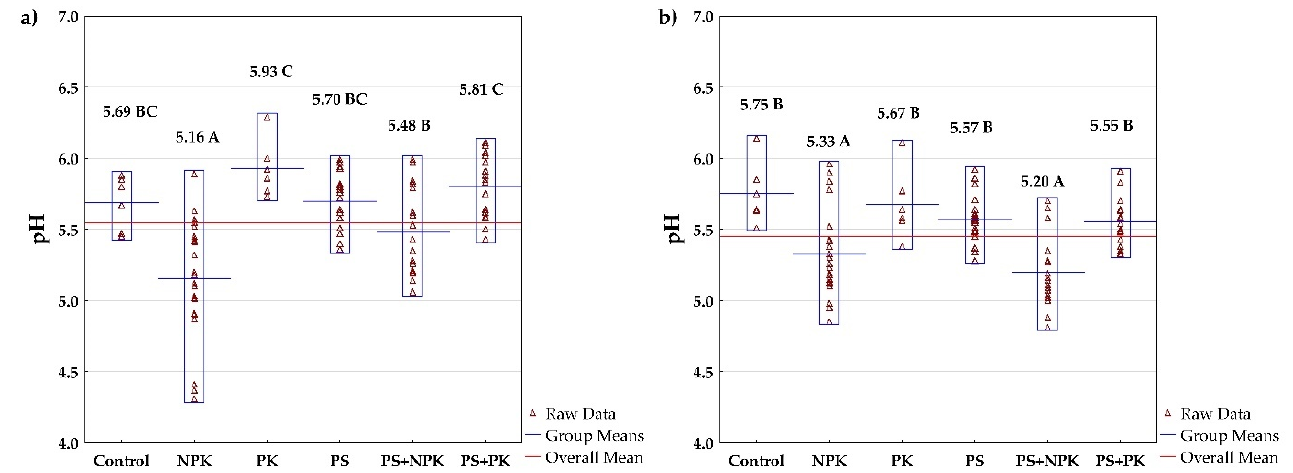
Figure 1. The effect of fertilizer treatments on pH in ( a ) Pernolec and ( b ) Kostelec (2015–2020). Mean values followed by the same letter are not significantly different. Red triangles represent the raw data. The blue lines represent the mean value of the particular treatment, while the red line represents the mean value calculated from all fertilizer treatments. Table 4. Soil pH value, the concentration of P, K, Ca and Mg (mg kg − 1 ), the content of organic carbon (Cox, %) and total nitrogen (Nt, %) as affected by the fertilizer treatments (2015–2020) in Pernolec.